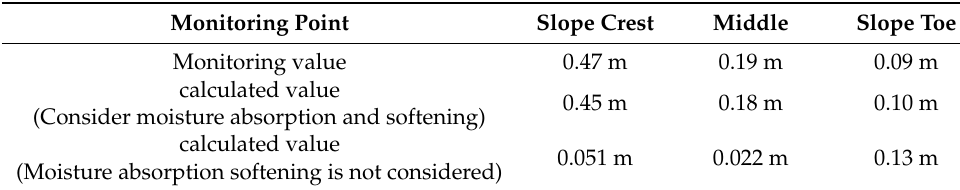
Table 4. Comparison of displacement calculation results.